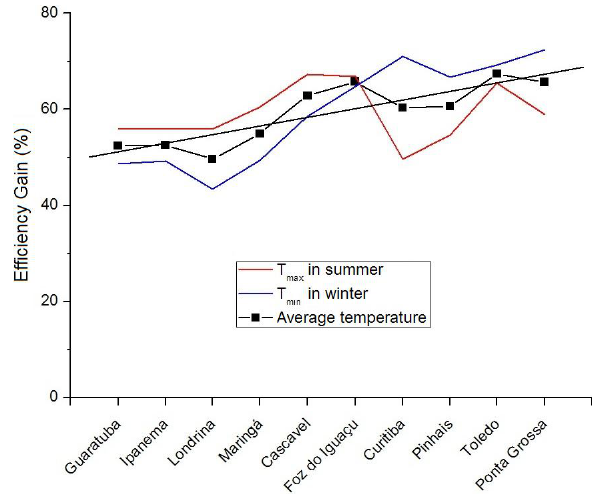
Figure 9: Efficiency gain as function of the winter outdoor temper- ature (measuring stations in descending order of winter external temperature).